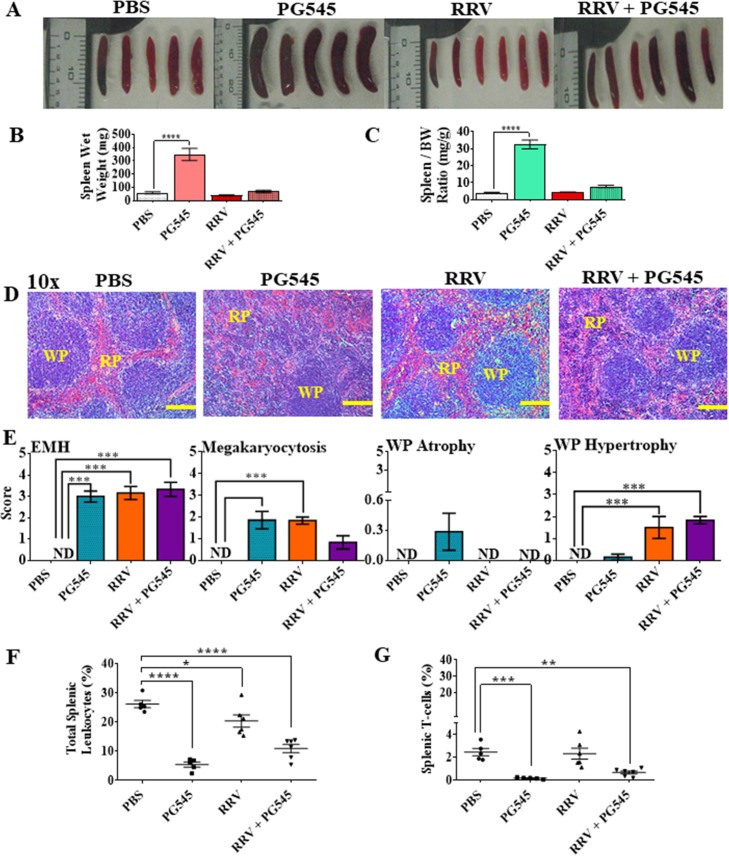
PG545 treatment induces extramedullary haematopoiesis in red pulp and white pulp atrophy.17-20-days-old C57BL/6 mice were infected s.c. with 104 PFU/50μl RRV or PBS alone and received s.c. injections of PG545 or mock-treatment with PBS on -1 and 4dpi (A) Representative spleens per treatment group were imaged. (B) Actual spleen weight and (C) relative organ/body weight ratios of mice from corresponding treatment groups were plotted. (D) Representative histomorphology of spleens sections stained with H&E (Scale bar; 10 x = 200 μm). (E) Spleen sections were assessed and scored according to level of EMH, megakaryocytosis, white pulp atrophy or hypertrophy. (F) Graphical representation of percentages of CD45+ infiltrating leukocytes and (G) CD3+ T-cells isolated from murine spleens per experimental group. Each data point represents the mean ± SEM (n = 5–7). RP, red pulp; WP, white pulp; EMH, extramedullary haematopoiesis; PBS, mock-infected PBS control; PG545, mock-infected PG545-treated; RRV, RRV-infected PBS-treated; RRV + PG545, RRV-infected PG545-treated.